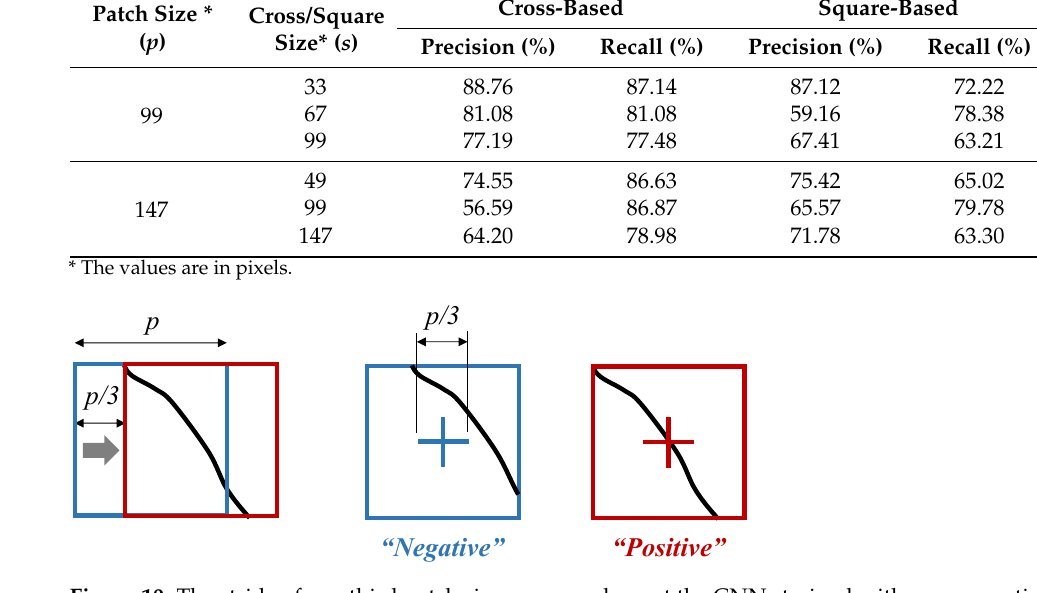
Figure 10. The stride of one third patch size can complement the CNNs trained with a conservative standard.